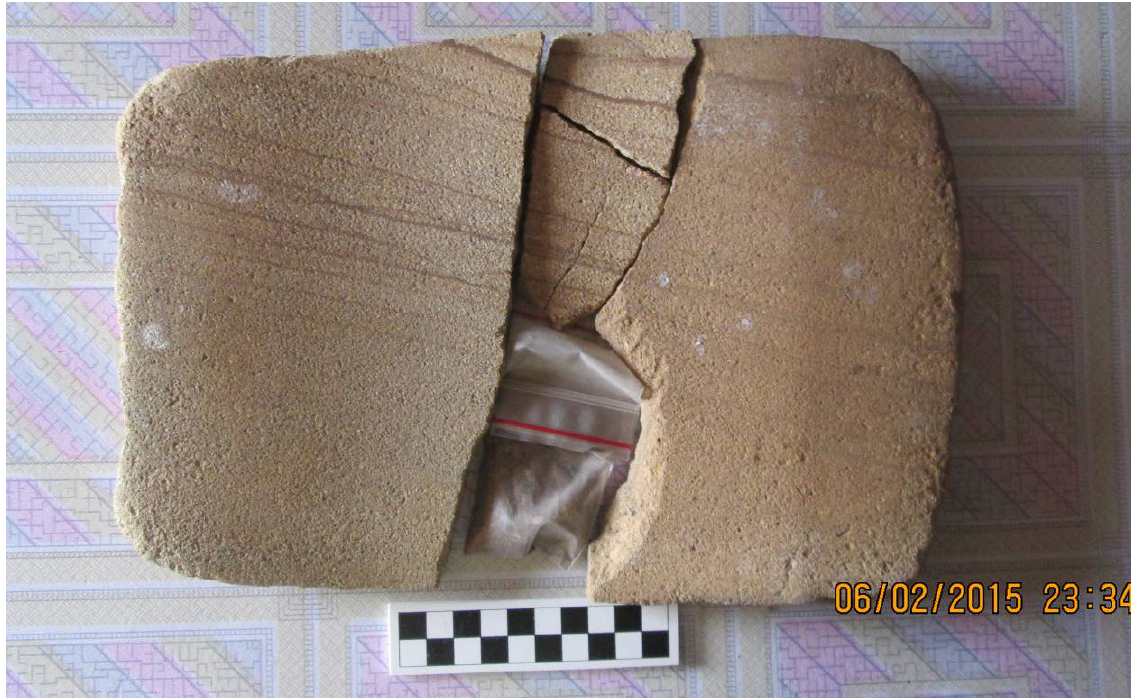
Figure 8. Nearly complete well-used milling platform that was collected in fragments in 2015 from Burgasny Enger (Ikh-28). Plastic bag contains associated sediment